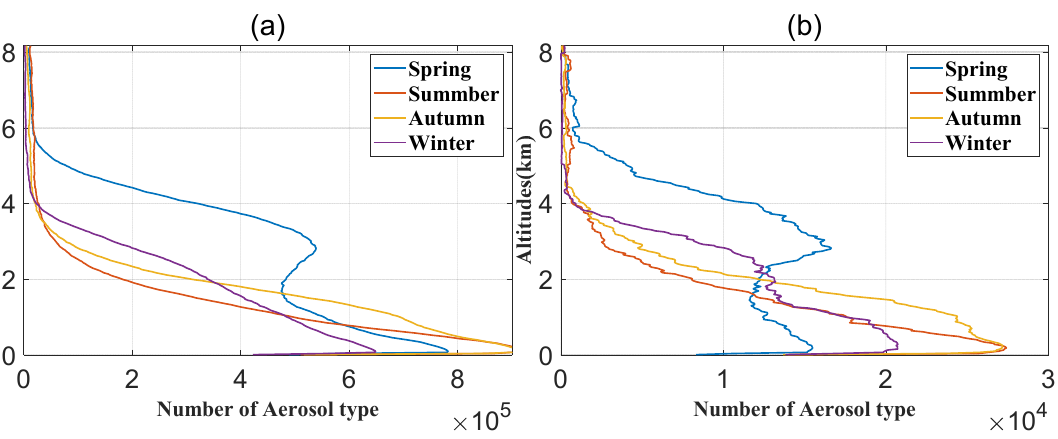
Figure 4. Seasonal variations of the number of all aerosol types with altitude over ( a ) the NSCS and ( b ) the coastal waters of the GBA (2006–2020).